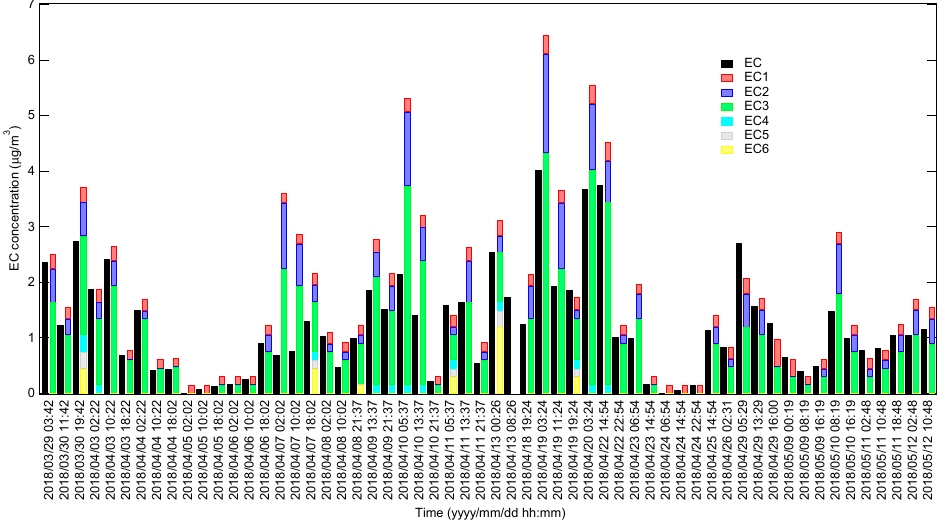
Figure 4. EC concentrations and EC fractions obtained through EGA in this study. Figure 5 shows the correlation of EC fractions and their combinations with the EC mass concentration. It was possible to determine a dominant EC fraction in EC mass concentration. As shown in Figure 5a, EC1, EC2 and EC3 concentrations versus EC mass concentration together with linear regression fitting curves demonstrated the contribution of individual EC fraction to EC. Figure 5b presents EC1 + EC2 concentrations versus EC mass concentration, which show the effect of the carbon oxidation at relatively low temperature. Figure 5c shows EC1 + EC3 concentrations versus EC mass concentration. Figure 5d shows EC2 + EC3 concentrations versus EC mass concentration. Figure 5e shows EC1 + EC2 + EC3 concentrations versus EC mass concentration. The slope, y-intercept, their standard deviations and R 2 of each graph are shown in Table 2. The slope of linear fitting curve of EC1 versus EC was the lowest, which implies that EC1 contributed to EC less than EC2 and EC3 did. Among EC1, EC2 and EC3, the slope of linear fitting curve of EC3 versus EC was the highest and R 2 of EC3 versus EC was the highest, too. Therefore, EC3 turned out to be the dominant fraction for the quantification of EC in the present study. As can be seen in Figure 5b–d and Table 2, EC1 + EC3 versus EC exhibited the highest correlation, while EC1 + EC2 versus EC showed the lowest correlation. The slope of the linear fitting curve of EC1 + EC2 + EC3 versus EC was larger than 1 as can be seen in Figure 5e and Table 2. This implies that EC1 + EC2 + EC3 was overestimated in comparison with EC. The comparison result on the correlations of EC fractions and their combinations with EC mass concentrations suggests that EC3 is the most dominant fraction to compose EC mass concentration. That is, EC3 is the most ‘appropriately’ correlated with EC as a single fraction, and is oxidized to CO 2 at 700 ◦ C. EC1 + EC3, among others, as a combination of multiple fractions is the ‘best’ correlated with